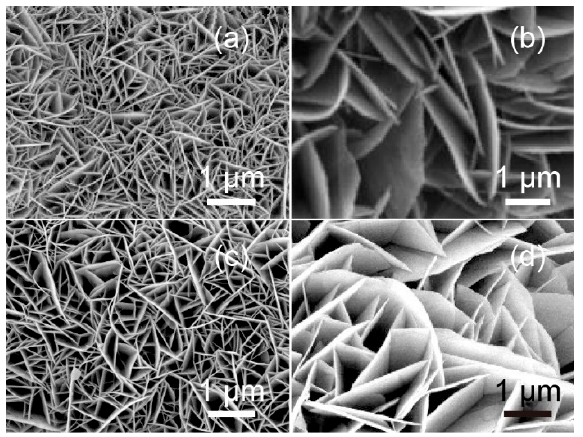
Figure 3. SEM images of ( a ) NiAl–LDH films, ( b ) NiFe–LDH films, ( c ) Fe-doped NiAl–LDH films, and ( d ) Fe-doped NiFe–LDH films.